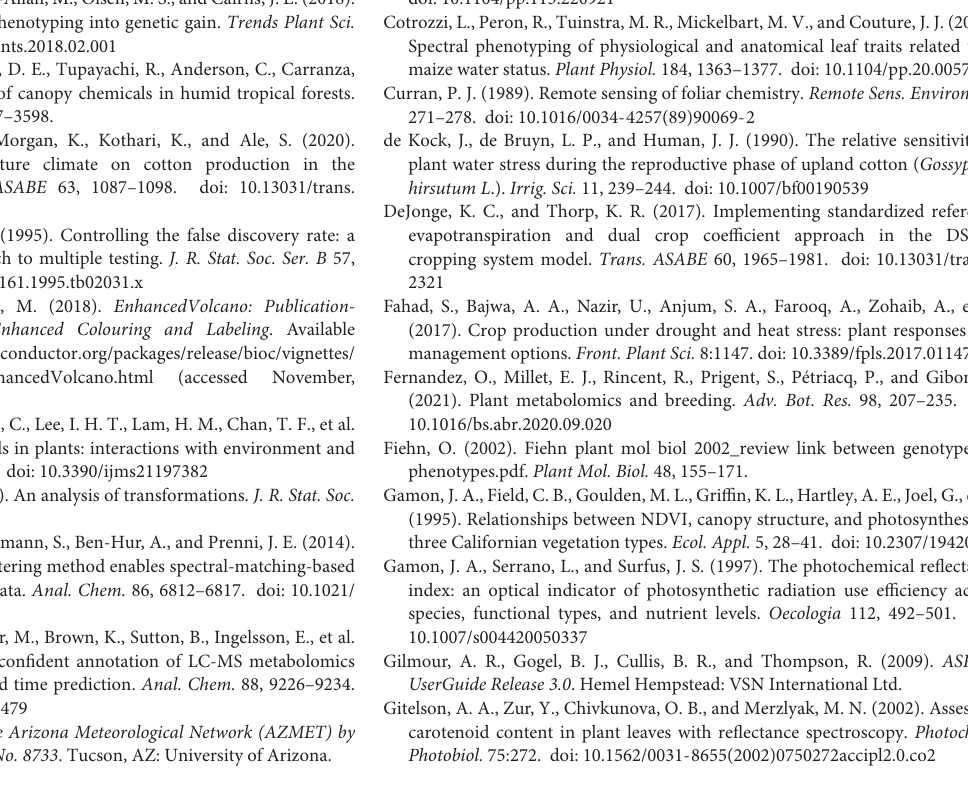
Supplementary Table 2 | Repeatability values and significance of fixed effects from the linear mixed models for the fiber traits of the 22 cotton accessions in 2018. Supplementary Table 3 | Repeatability values and significance of fixed effects from the linear mixed models for the fiber traits of the 22 cotton accessions in 2019.